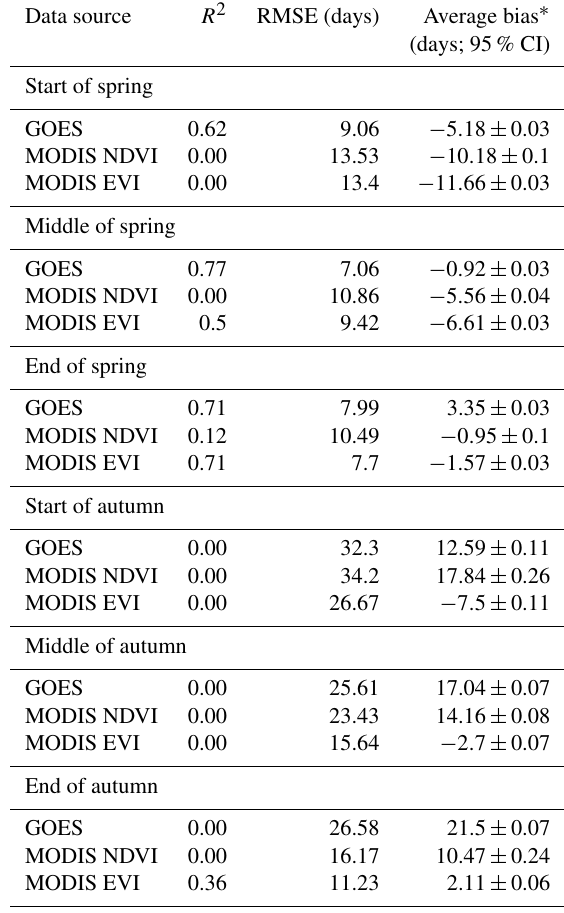
Table 3. Summary statistics for comparisons with PhenoCam tran- sition